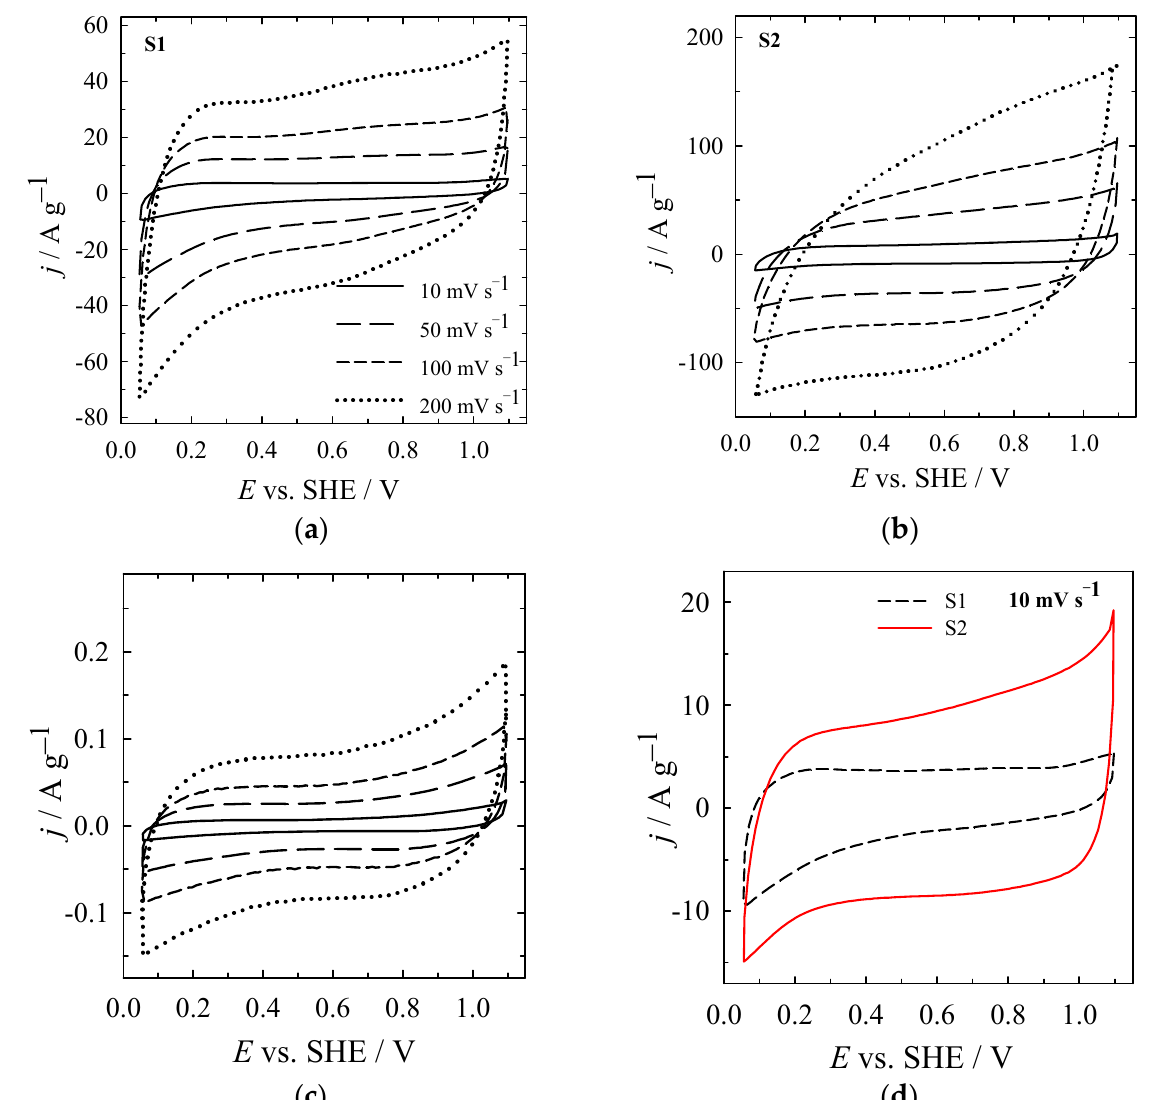
Figure 5. CVs of: ( a ) sample S1; ( b ) sample S2; ( c ) carbon were recorded in 1 M Na 2 SO 4 at different scan rates. ( d ) CVs of samples S1 and S2 at 10 mV s − 1 .